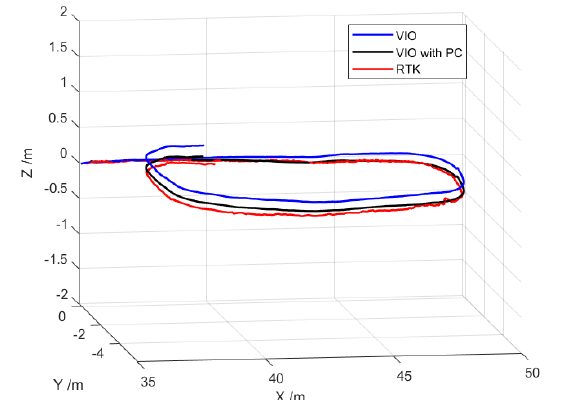
Figure 6. Comparation with and without planar